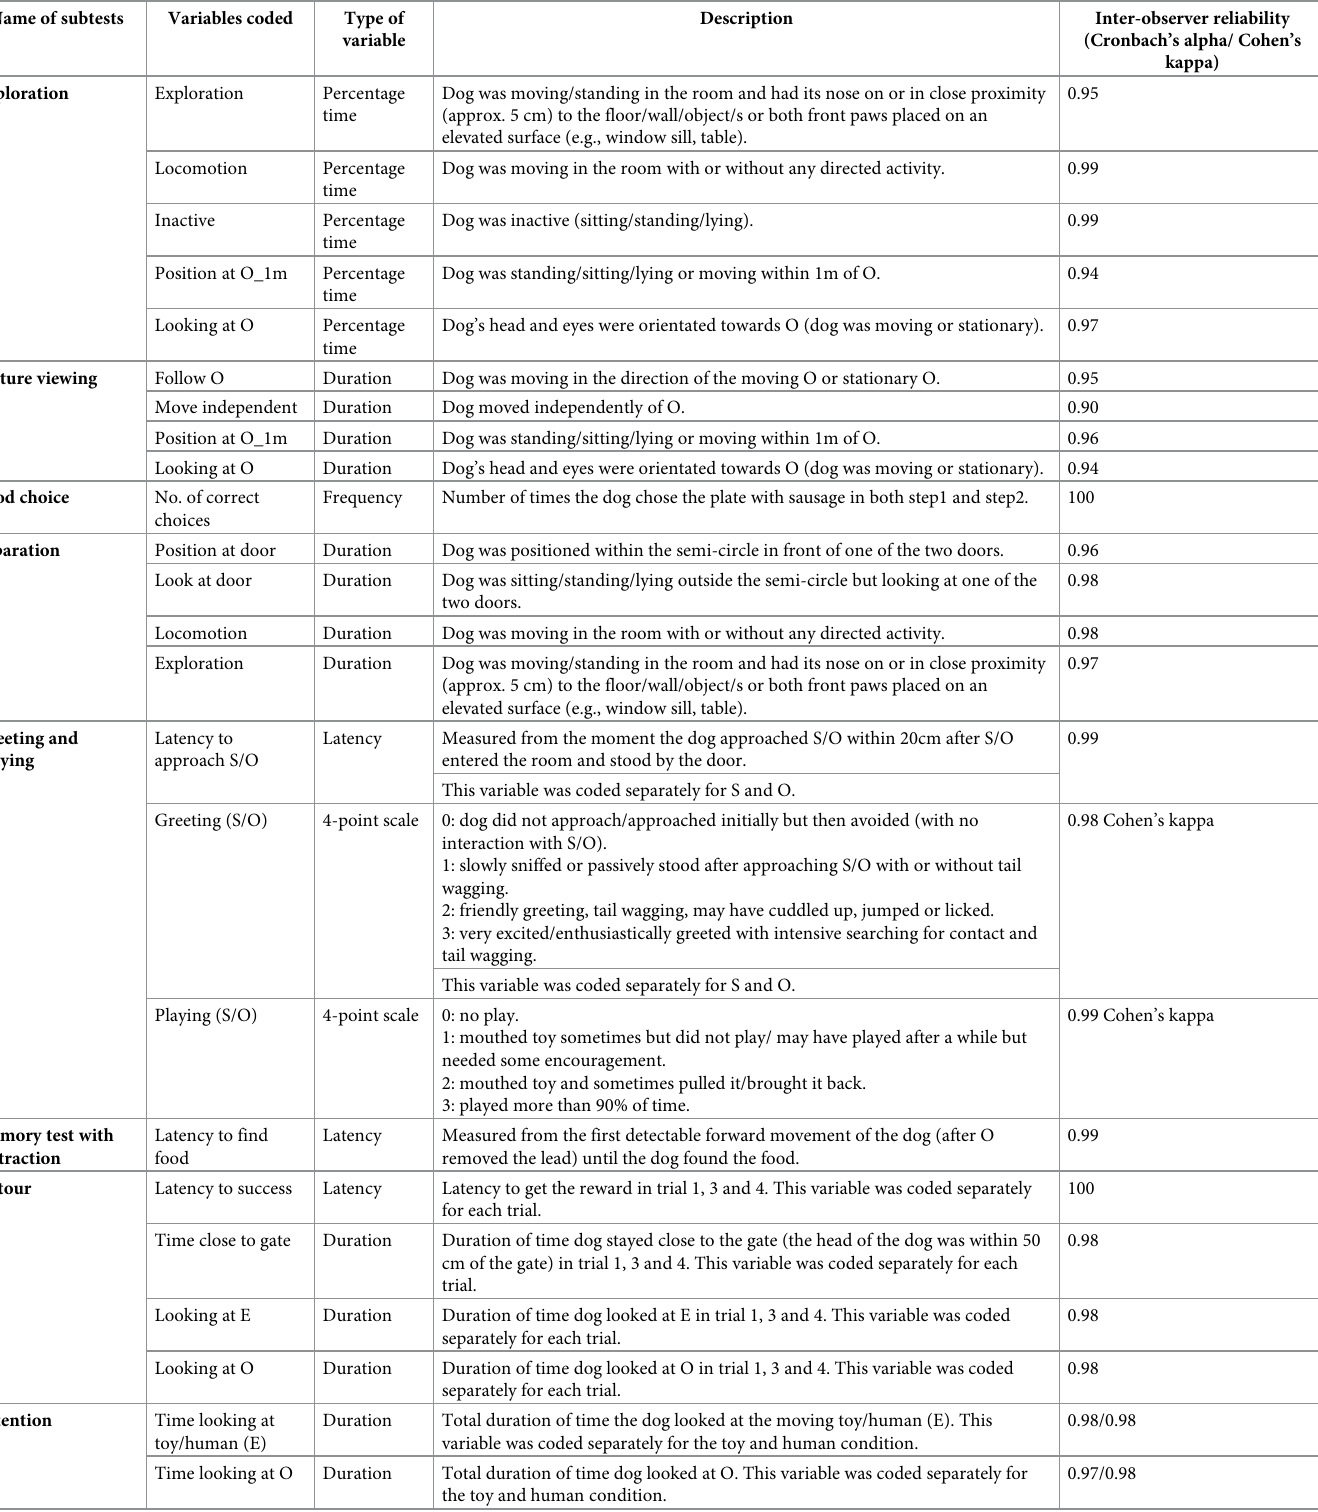
Table 3. Detailed description of all behavioural variables measured in 11 subtests in MVCCB 2. Name of